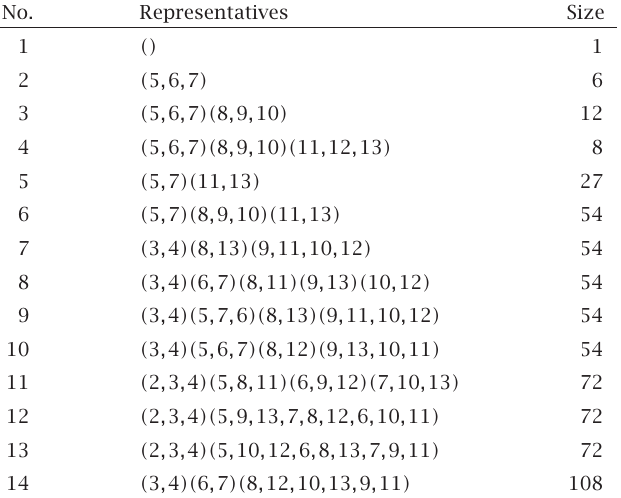
Table 2.1 . The representatives of conjugacy